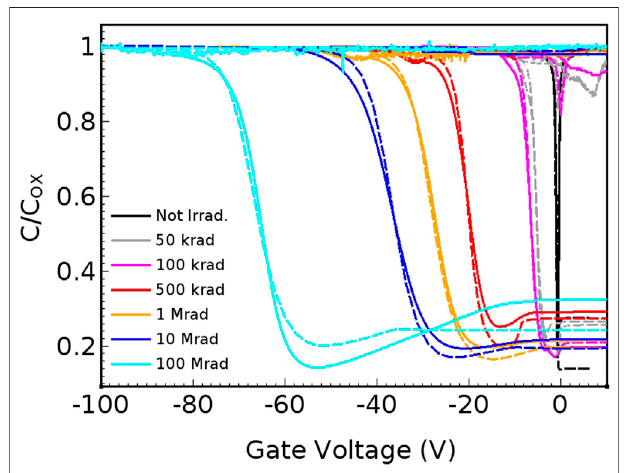
FIGURE 8 | C-V characteristics of IFX MOS capacitors: comparison between simulated and experimental data for 8 ″ process (solid line measurements, dashed lines simulations).